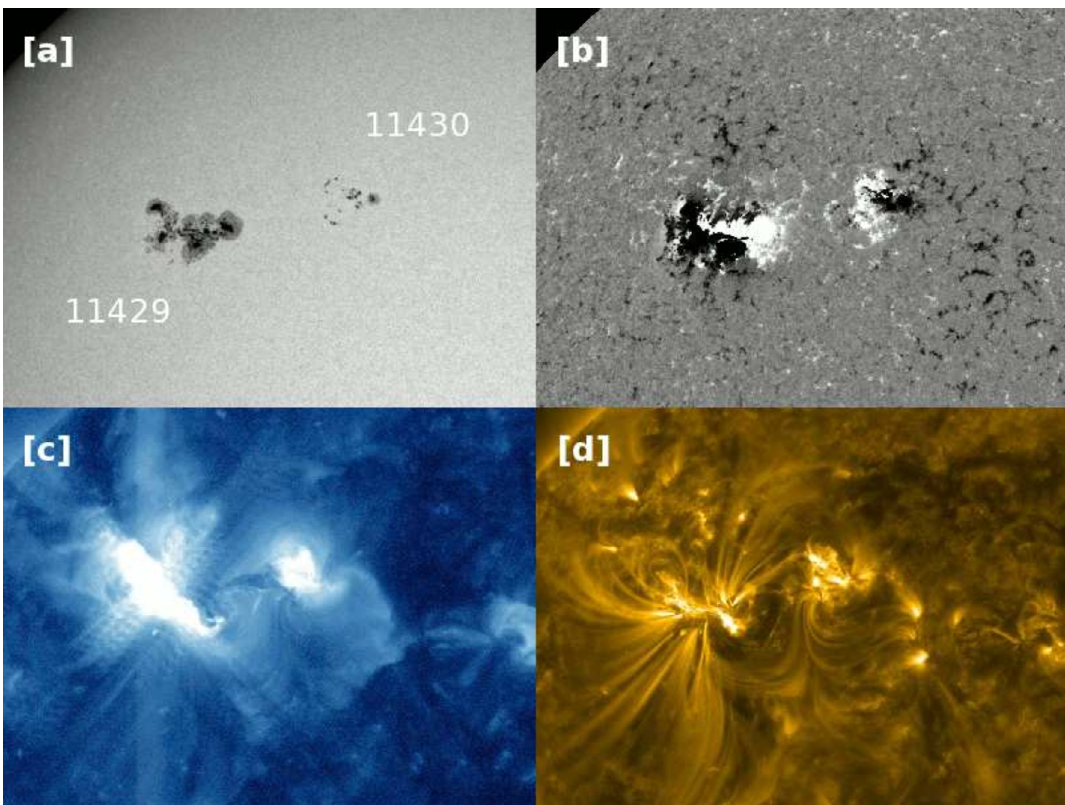
Fig. 1. Active regions AR11429 and AR11430 as observed by SDO imagers around the March 7th event: (a) SDO/HMI Continuum; (b) SDO/ HMI Magnetogram; (c) SDO/AIA 335 A˚ ; [d] SDO/AIA 171 A˚